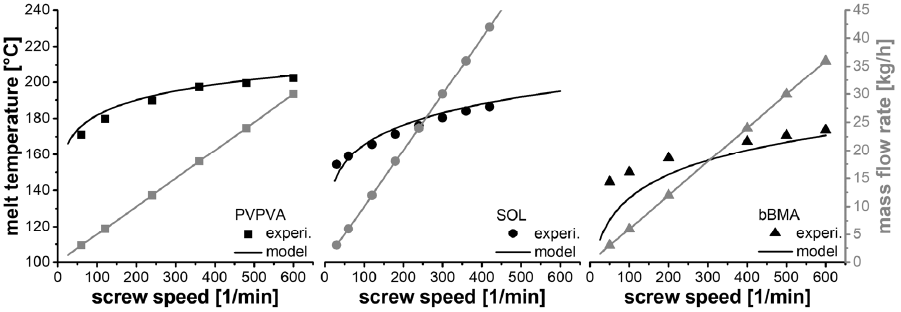
Figure 7. Comparison between modelled and experimental data considering melt temperature (black) and mass flow rate (grey). The extruder parameters for modelling one polymer were derived from the two other polymers.